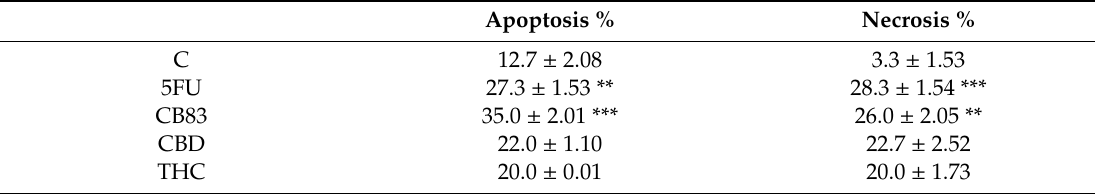
Data are representative of three independent experiments and are presented as mean ± S.D. Data were statistically evaluated ** p < 0.01, and *** p < 0.001.